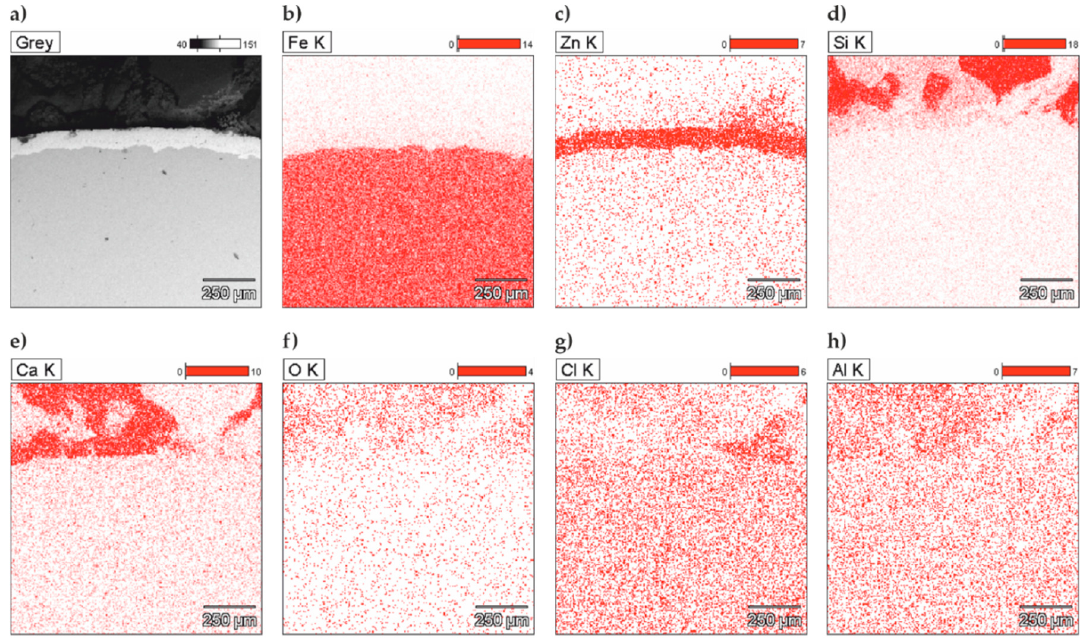
Figure 17. ( a ) Microstructure of the surface of tested concrete without chlorides—reinforcing steel B500SP with zinc coating (SEM) and relative concentrations of elements on the surface (mapping): ( b ) Fe, ( c ) Zn, ( d ) Si, ( e ) Ca, ( f ) O, ( g ) Cl, and ( h ) Al (EDS).